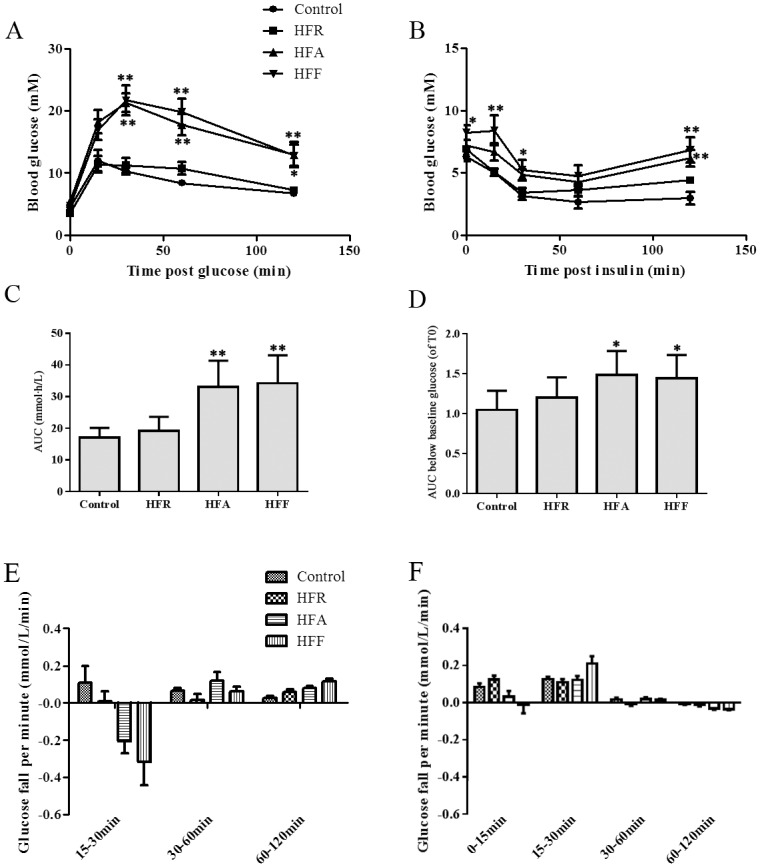
Effect of diet modification on insulin sensitivity.Mice fed with fructose water or high fat diet were subjected to intraperitoneal glucose tolerance tests (A) and intraperitoneal insulin tolerance tests (B). The areas under the curve (AUC, C and D) and the glucose disappearance rate (E and F) were calculated to detect differences among the groups. Data are presented as means ± SD (n ≥ 6 in each group). A significant difference was determined by one-way analysis of variance. *P < 0.05 versus control at the same time point, **P < 0.01 versus control at the same time point.